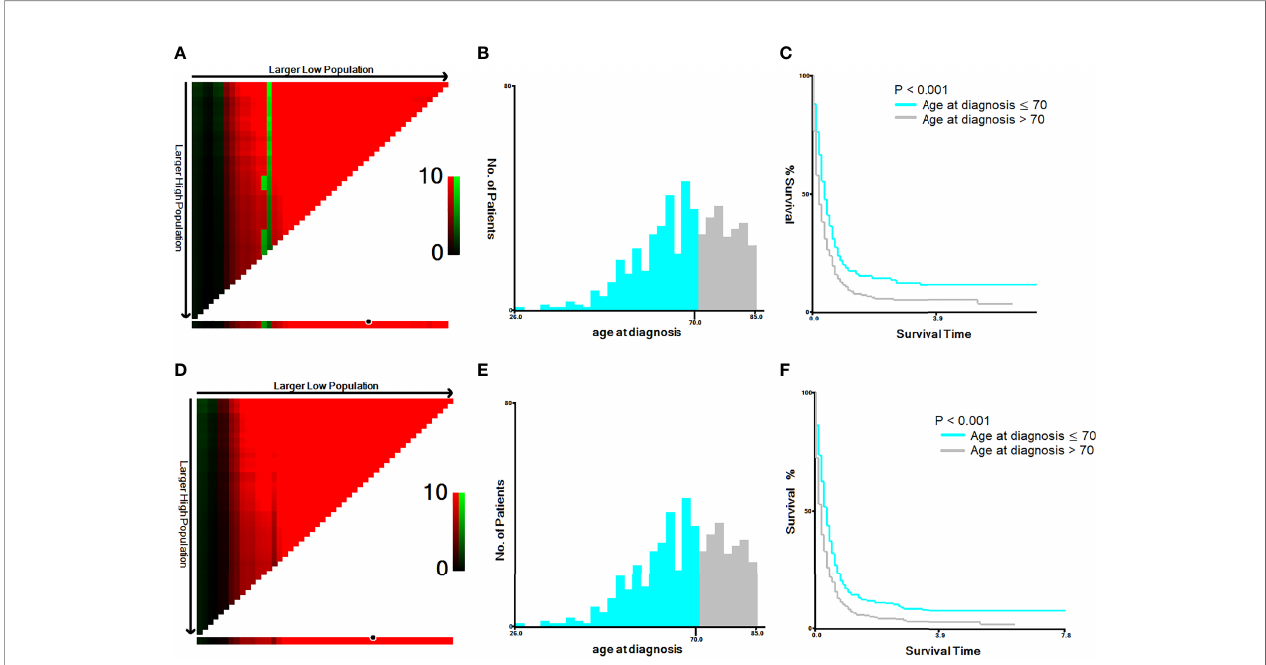
FIGURE 1 | X-tile analysis of 586 anaplastic thyroid cancer patients based on cancer-speci fi c mortality and overall mortality. ABBREVIATION: The training plots are shown in panel (A, D), with matched validation sets shown in panels (B, E) and (C, F) . The optimal cut-point highlighted by the black circle in panel (A, D) is shown on a histogram of the entire cohort (B, E) and a Kaplan-Meier plot (C, F) . The picture of (A – C) is for cancer-speci fi c mortality; the picture (D – F) is for overall mortality. P values were determined by using the cut-point de fi ned in the training set and applying it to the validation sets (P < 0.001).